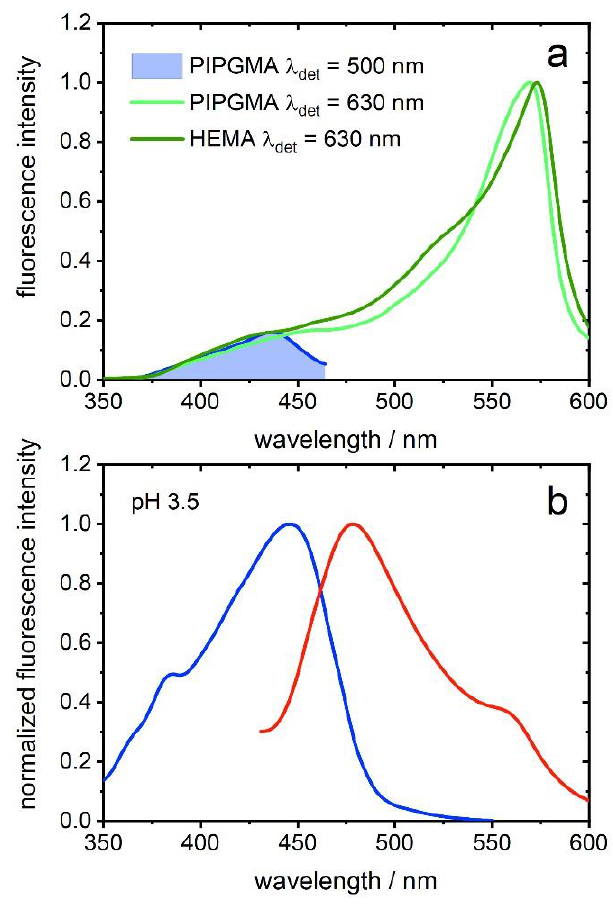
Figure 7. ( a ) Excitation spectra of PIPGMA- and HEMA-containing opal films at indicated detection wavelength λ det. ; ( b ) excitation ( λ det = 600 nm) and emission spectrum ( λ exc = 400 nm) of a PGMMA-containing opal film swollen in water (pH 3.5) for 72 h.